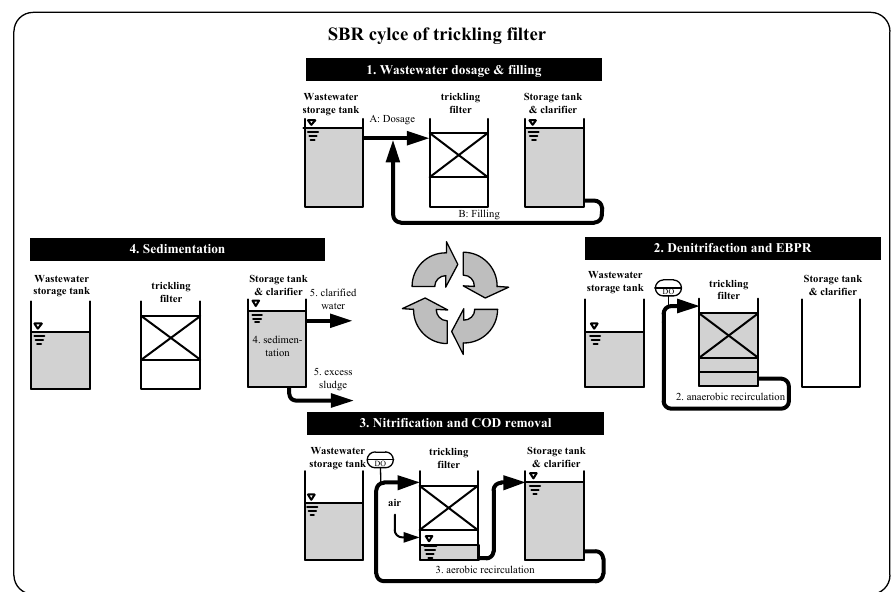
Figure 5. Steps of one SBR cycle [27].